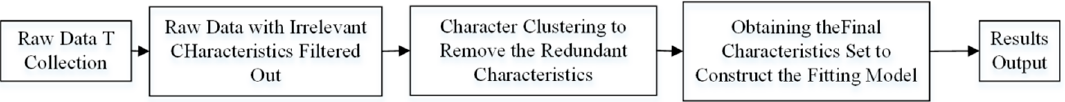
Figure 1. Selection of the characteristic parameters of the abdominal obesity prediction model.